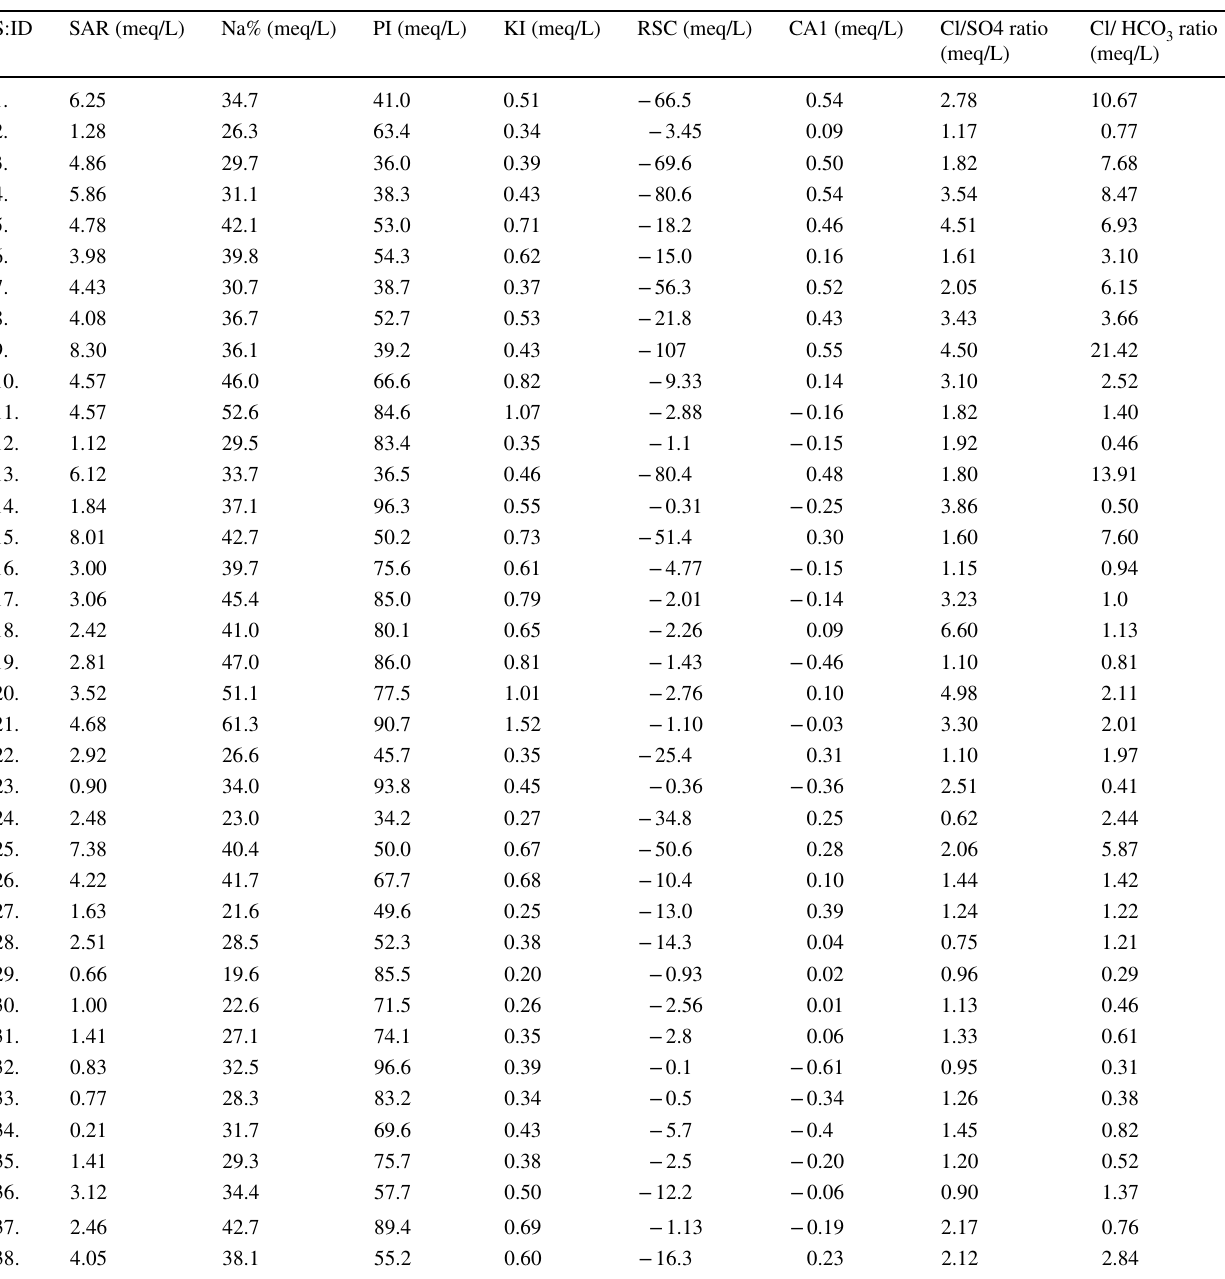
Table 6 Suitability of water for